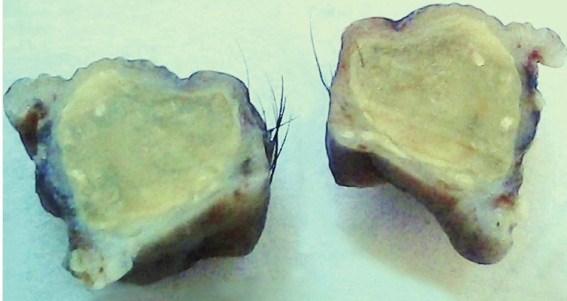
Figure 2: Gross photograph of full thickness pentagonal excision of eyelid shows well circumscribed cyst filled with solid, homogenous material with spotty greyish white chalky areas.